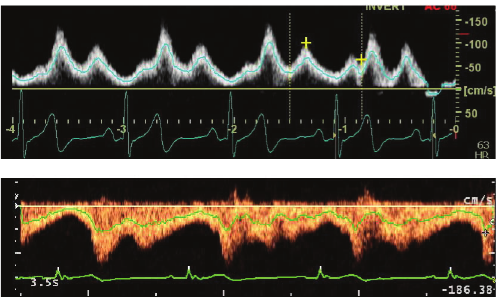
Figure 3: Ultrasound spectral Doppler trace of the right internal jugular vein blood flow. The mean velocity trace is highlighted.